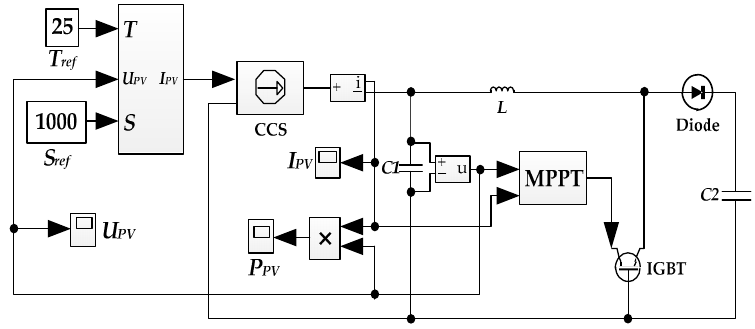
Figure 2. A simulation model of a photovoltaic cell. CCS: controlled current source; IGBT: Insulated Gate Bipolar Transistor; MPPT: Maximum Power Point